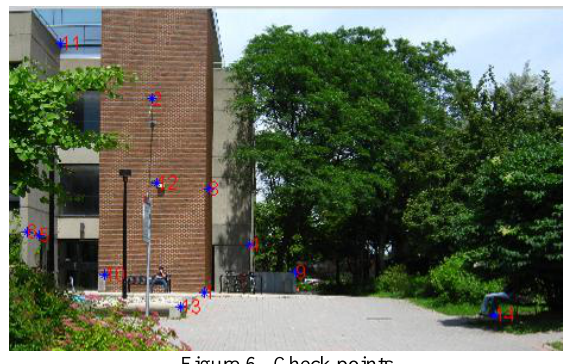
Figure 6. Check points